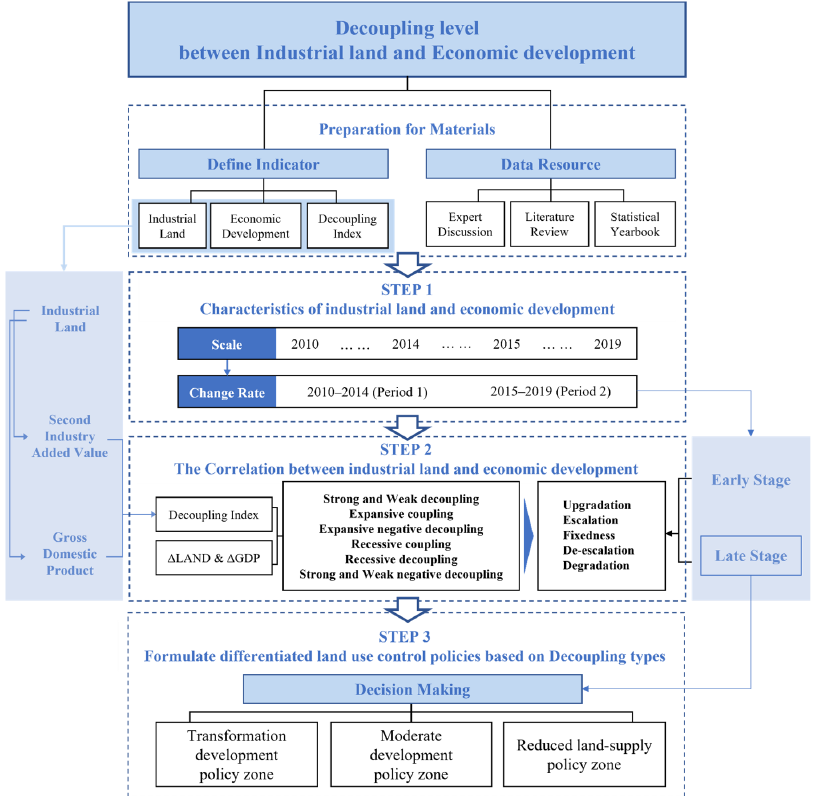
Figure3. The research framework of decoupling degree to evaluation. Figure 3. The research framework of decoupling degree to